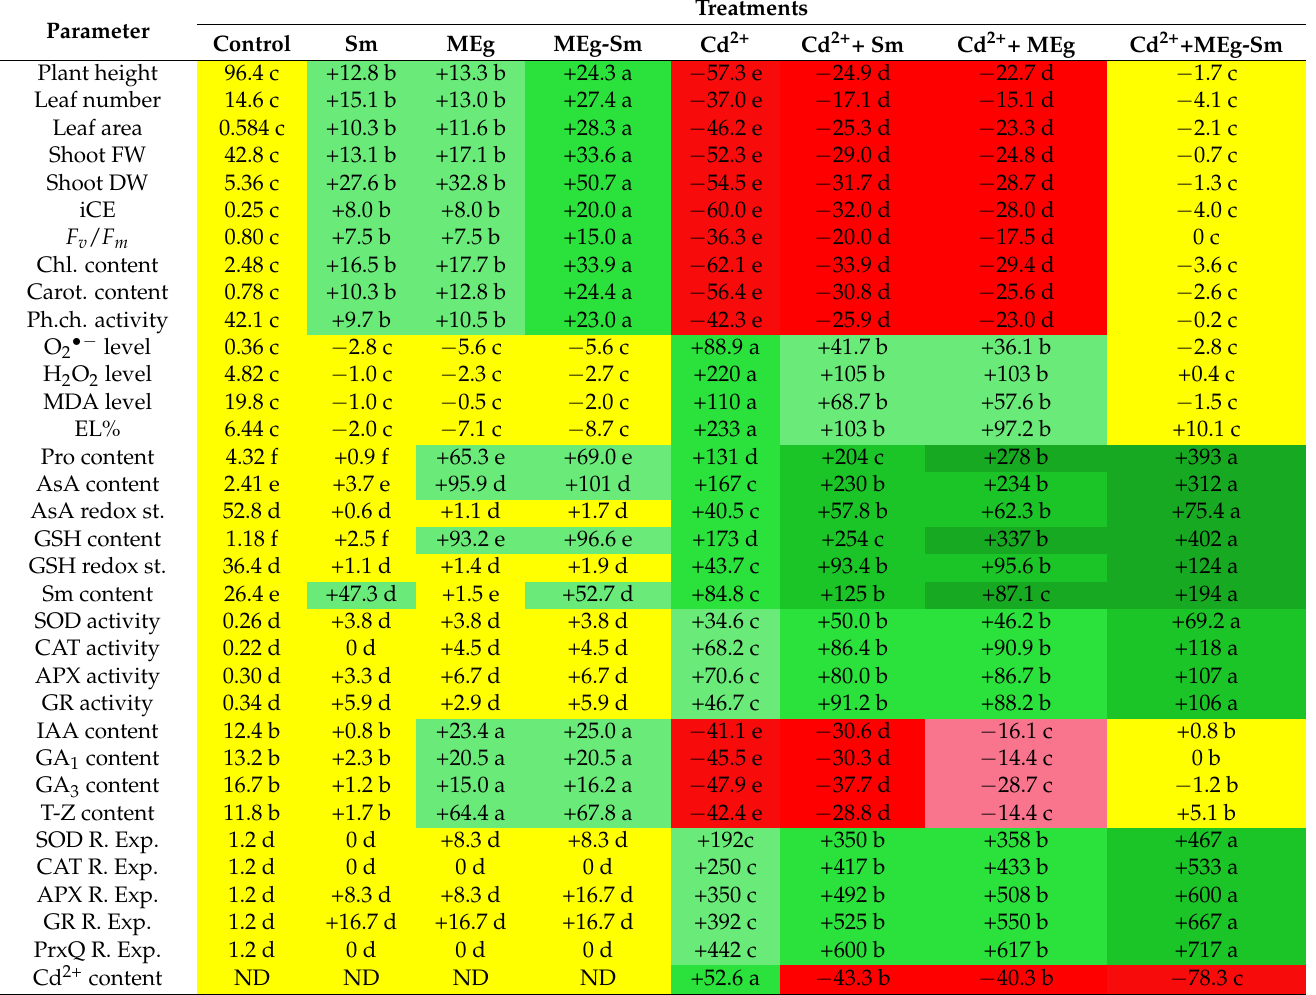
Table 6. Changes (%) in morphophysiobiochemistry attributes, and relative expression of antioxidant enzyme genes relative to the control in Cd-stressed maize plants treated with maize grain extract enriched with silymarin. Three color scale heatmap, yellow as the midpoint of control and parameters with insignificant values compared to control, red for changes below control values, and green for changes over control